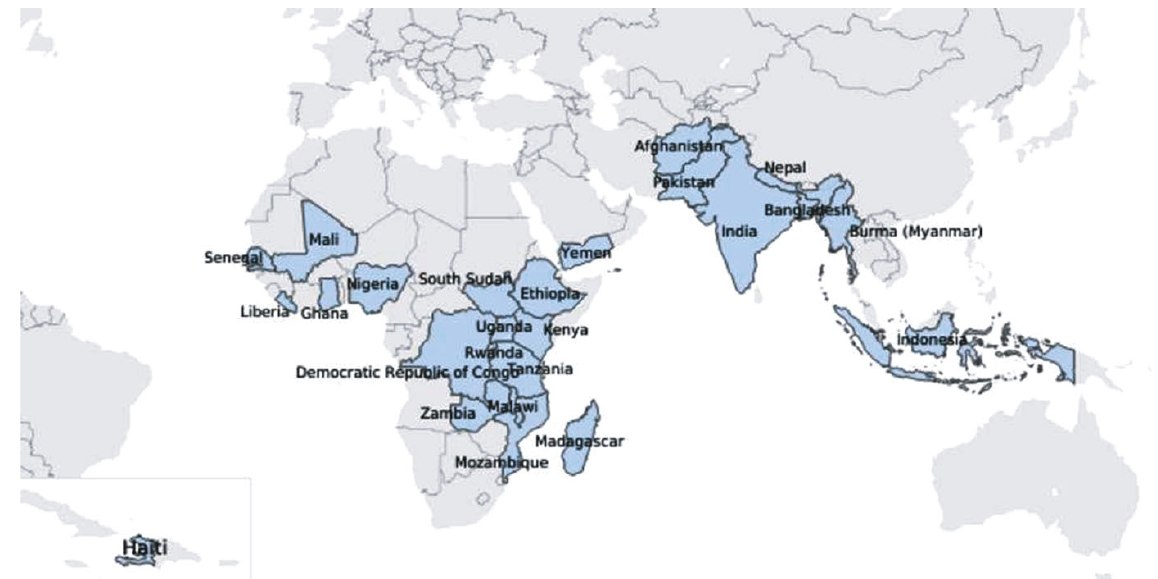
Figure 1: USAID ’ s MCHN map. This map depicts USAID ’ s MCHN priority countries that were investigated in creation of the algorithmic tool to assess e ff ectiveness of candidate maternal RSV vaccination on reducing infant incidence and mortality in developing countries. Data for South Sudan were not available.